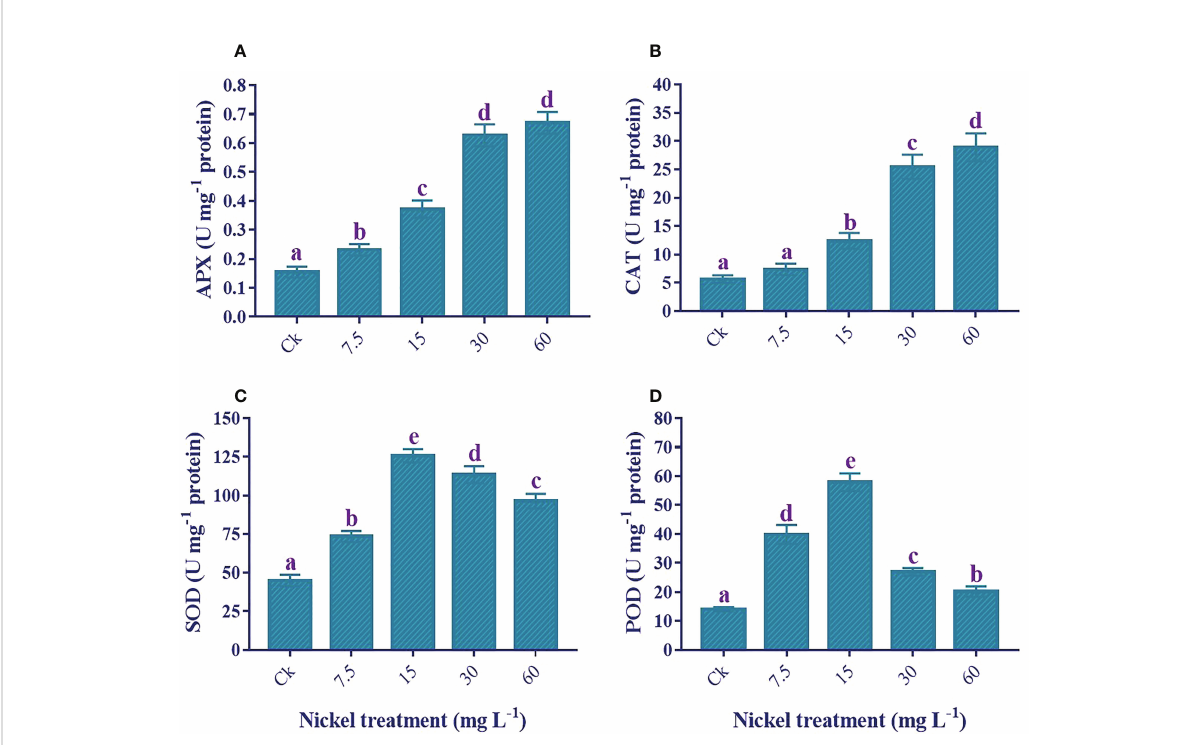
FIGURE 8 Effect of different Ni treatments on the antioxidant enzymes in the leaves of sweetpotato. (A) APX, (B) CAT, (C) SOD, and (D) POD. According to the Duncan test, different letters indicate a signi fi cant difference ( p < 0.05) among the fi ve treatments. The error bars represent the mean ±